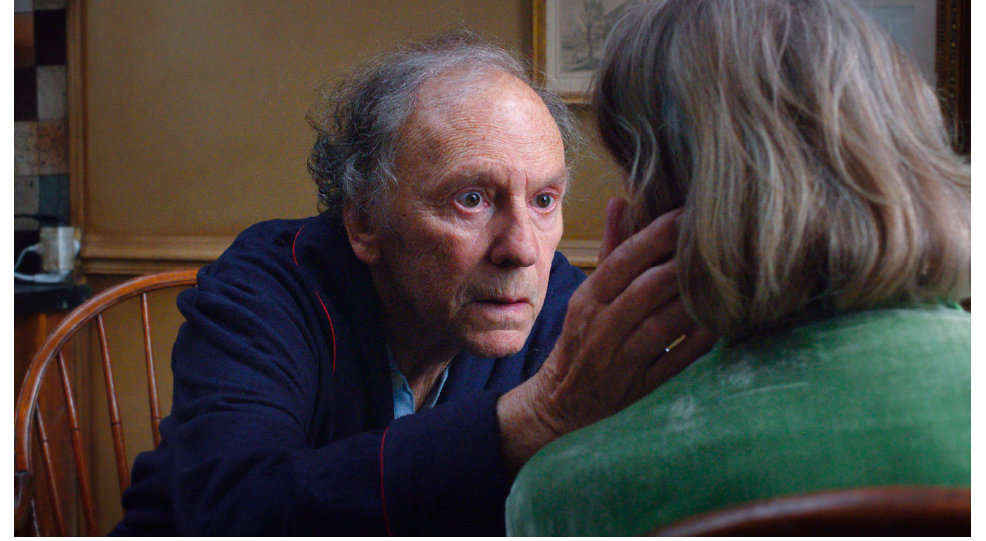
Figure 4. Georges begins to lose touch with Anne.